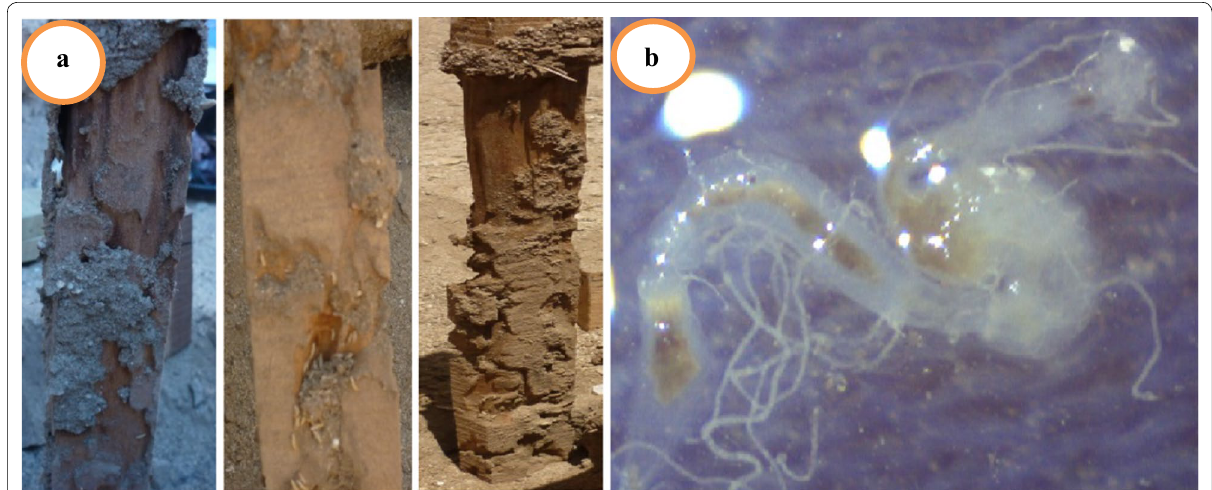
Fig. 1 a Symptoms of wood damage by the subterranean termite, b gut of the subterranean termite Psammotermes hypostoma Desneux